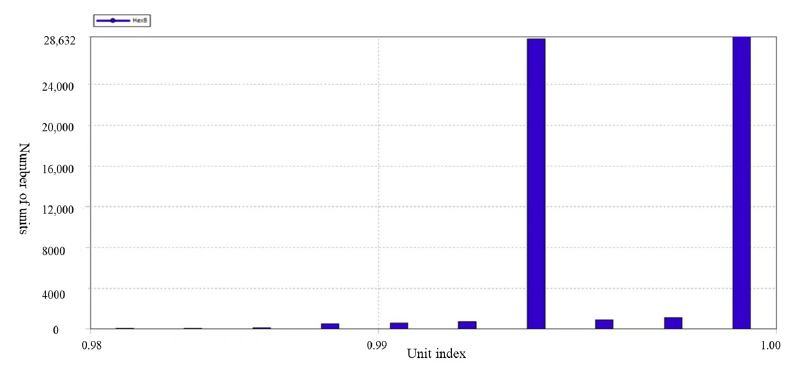
Figure 4. Mesh quality distribution diagram (own elaboration).